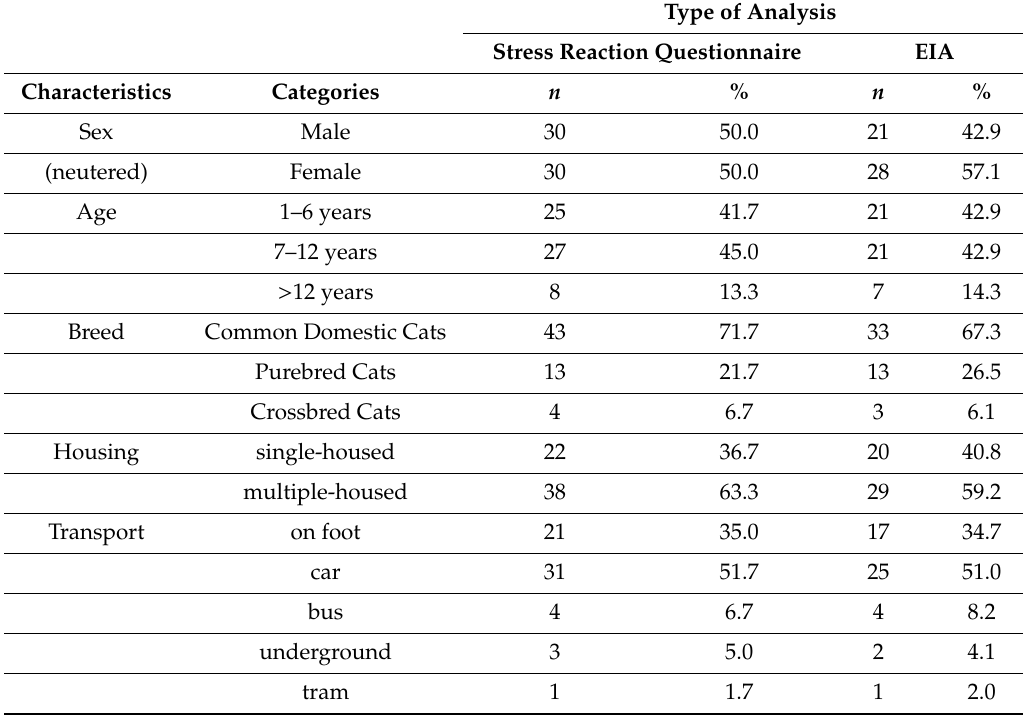
Table 2. Characteristics of participating cats ( n = 60;